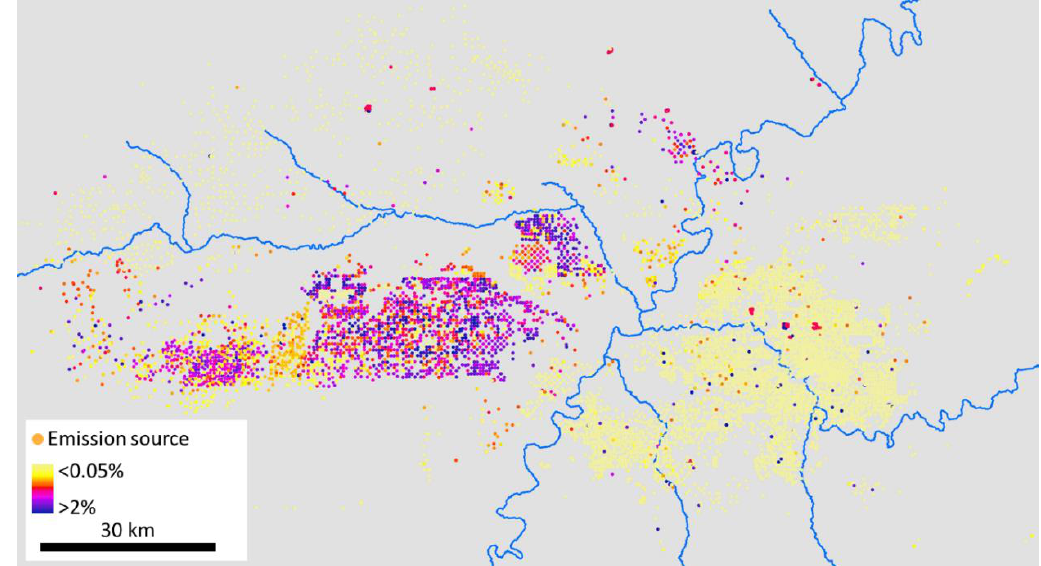
Figure 8. Oil and gas-related emission sources listed in the 2014 Utah Air Agencies Inventory, colored by the alkenes+acetylene:alkane ratio.